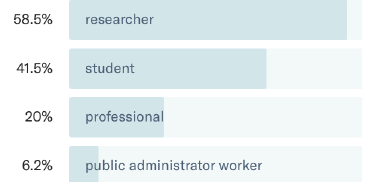
Figure 3. Kind of affiliation of the registered participants.